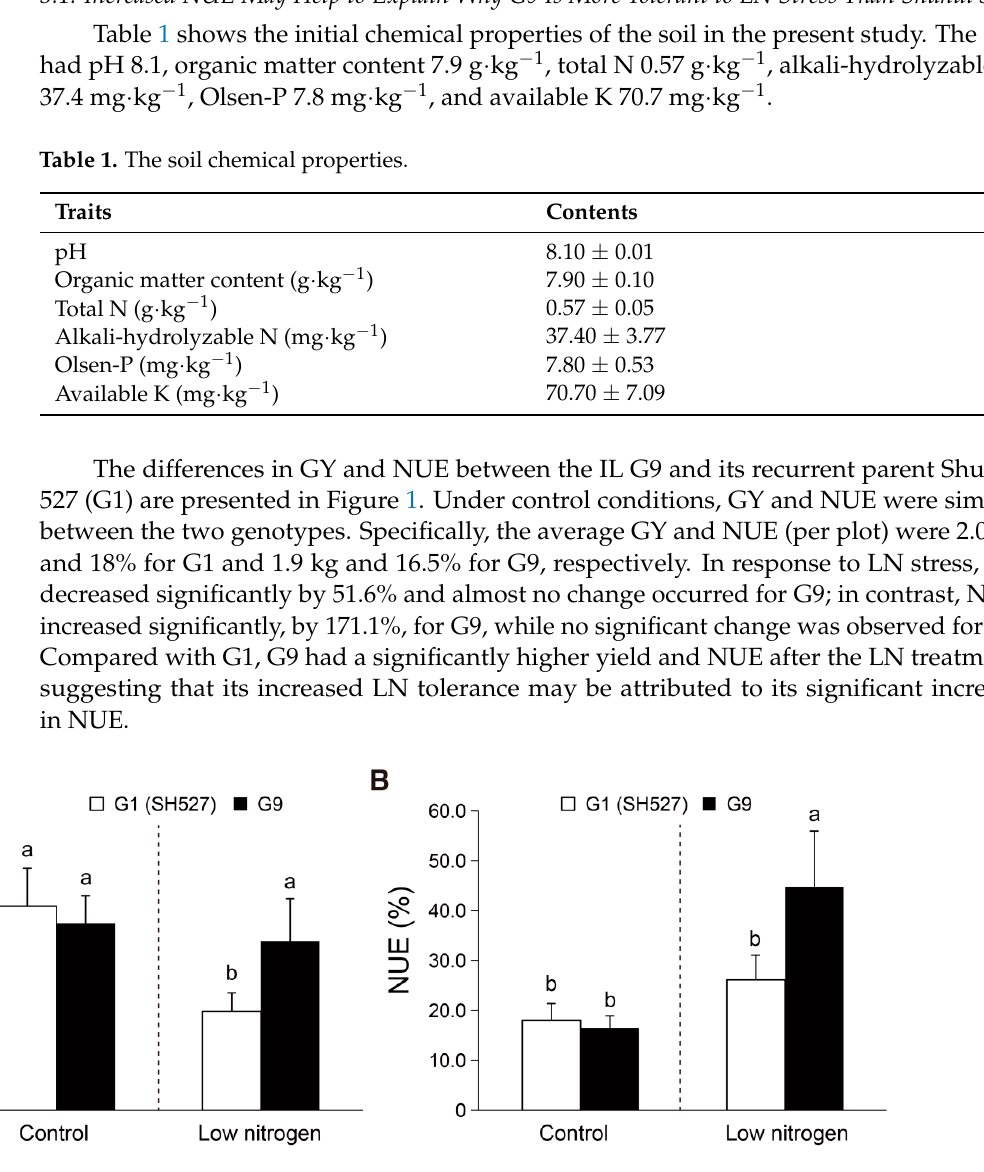
Figure 1. The performance of G9 and G1 under low nitrogen and control conditions. ( A ) Plot yield. ( B ) NUE. Bars represent the standard deviation of three biological replicates. The letter (a, b) indicates a significant difference between G9 and G1 under the same condition and between the two conditions within each genotype at the p ≤ 0.05 level.